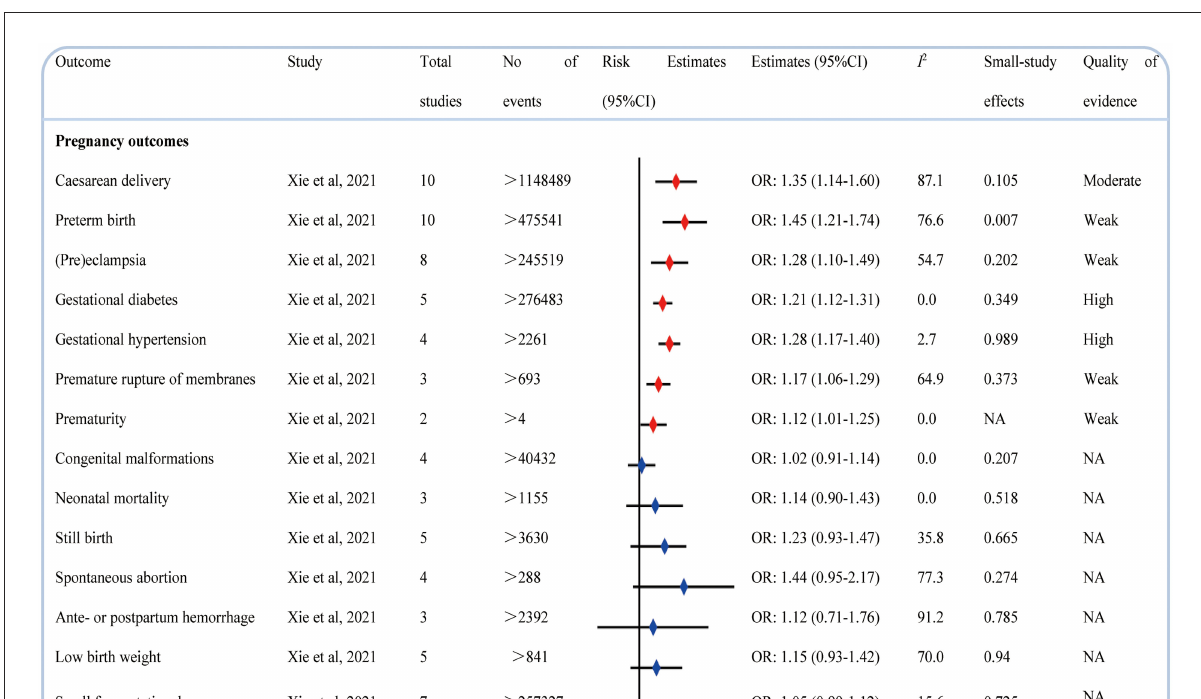
a broad overview of the association between psoriasis and other medical end points. The results covered